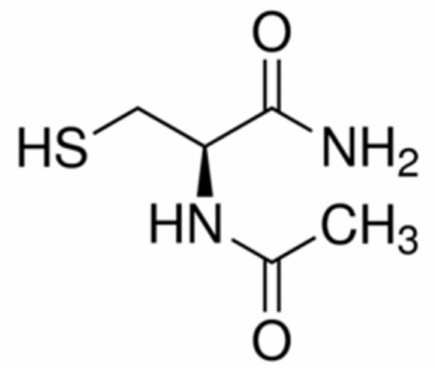
Figure 5. Molecular structure of